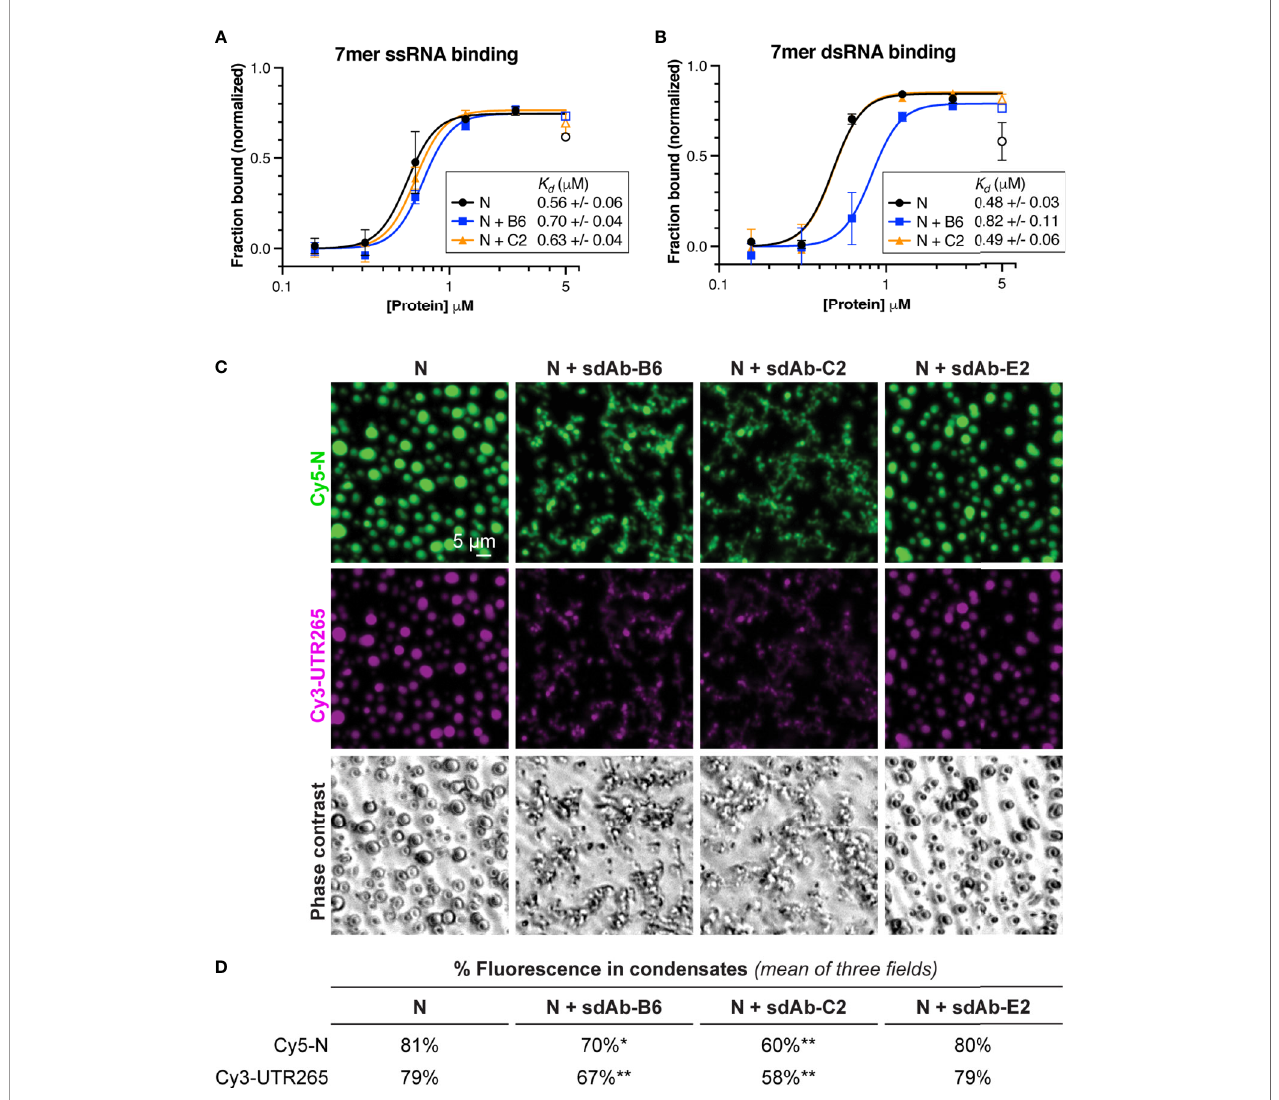
FIGURE 4 | RBD-targeting sdAbs targeting affect RNA binding af fi nity and RNA-mediated phase separation of SARS-CoV-2 N. (A) Binding curves for SARS-CoV-2 N (full-length protein) binding to a 7-mer single-stranded RNA, in the absence of added sdAbs (black points) or in the presence of equimolar sdAb-B6 (blue points) or sdAb-C2 (orange points). See Supplementary Figure 3A for example electrophoretic mobility shift (EMSA) gels. (B) Binding curves for SARS-CoV-2 N binding to a 7-mer double-stranded RNA, in the absence of added sdAbs (black points) or in the presence of equimolar sdAb-B6 (blue points) or sdAb-C2 (orange points). See Supplementary Figure 3C for example electrophoretic mobility shift (EMSA) gels. (C) In vitro phase separation of Cy5-labeled N (green) and Cy3-labeled UTR265 RNA (magenta), in the absence or presence of equimolar sdAb-B6, sdAb-C2, or sdAb-E2. (D) Quantitation of fl uorescence (protein and RNA) in condensates. All measurements represent the mean of three separate microscope fi elds. Asterisks indicate P-values from unpaired t-tests: *P < 0.05, **P <